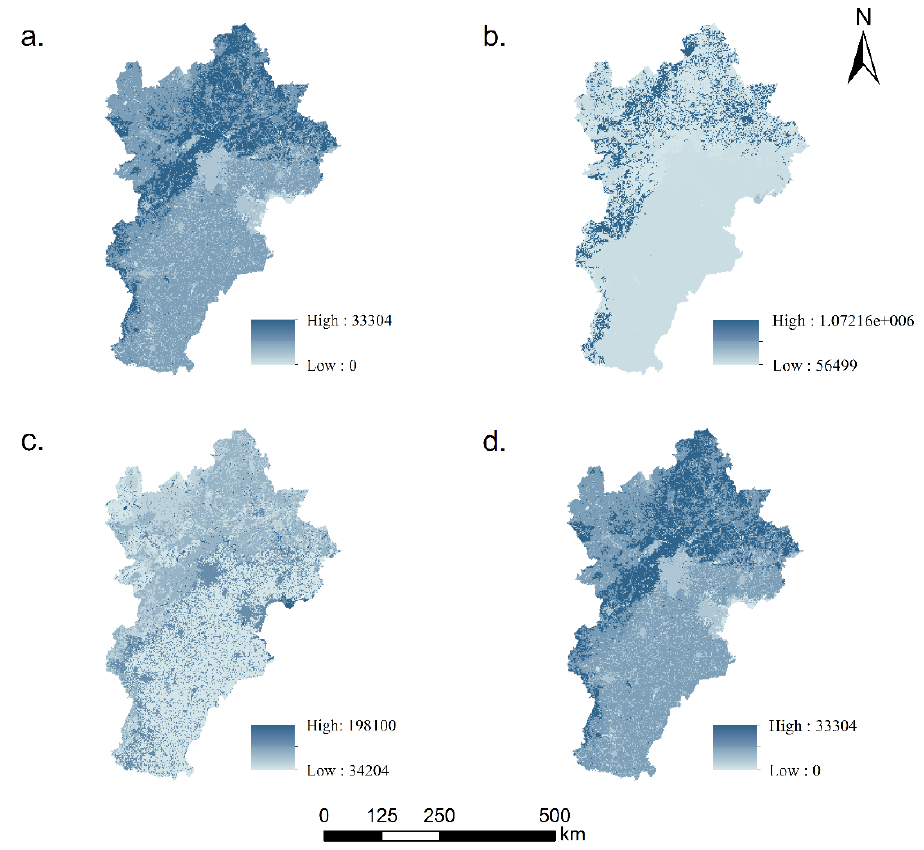
Figure 5. Distribution of carbon storage under different scenarios. ( a ) 2015; ( b ) conservation scenario; ( c ) development scenario; ( d ) natural scenario.